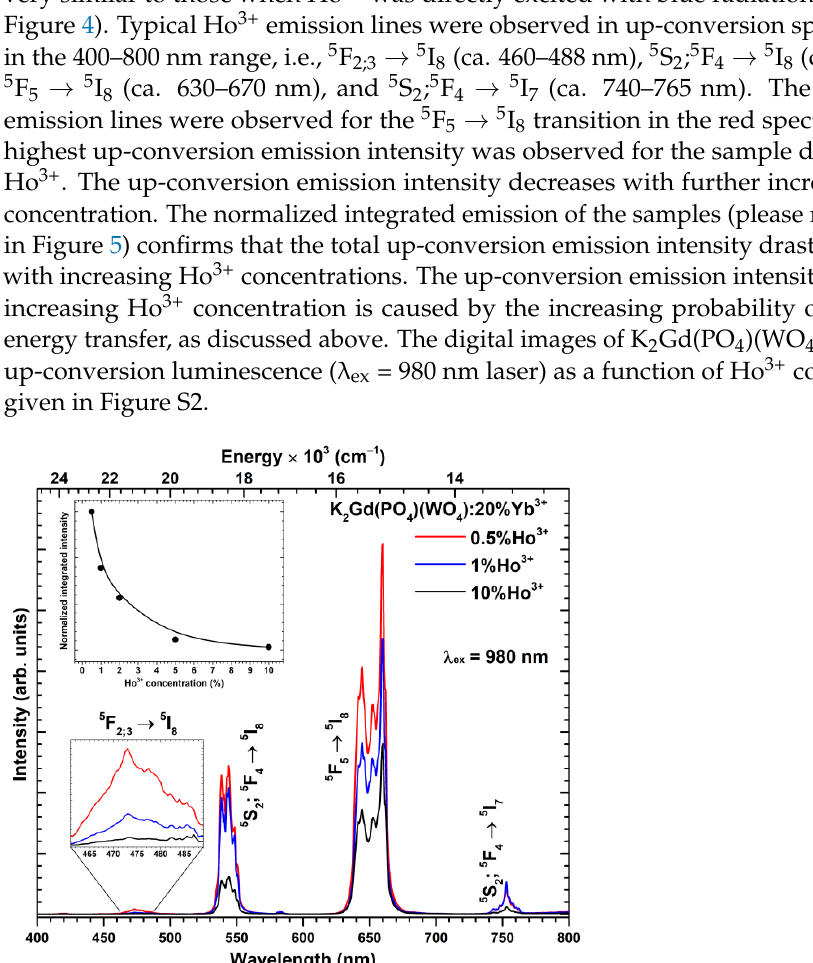
Figure 6a – c, in turn, show the calculated PL rise time and τ eff values of the same samples, respectively. The PL decay curves become steeper with increasing Ho 3+ concentration, in- dicating that PL lifetime values decrease. This indeed is true since the calculated τ eff values decreased from 191 μ s for 0.5% Ho 3+ doped samples to 83 μ s for 10% Ho 3+ doped samples (please refer to Figure 6c). The opposite tendency, however, was observed for the PL rise time values, which increased with increasing Ho 3+ concentration. The exact calculated PL rise time and lifetime values, together with standard deviations, are summarized in Table S6. The calculated UC PL lifetime values for 5 F 5 → 5 I 8 transition are very similar to the ones reported by other authors in a wide variety of materials, i.e., oxides, phosphates, titanates, silicates, tungsten tellurite glasses, and even fluorides. For instance, Guo et al. reported that the UC PL lifetime value of BaGdF 5 :20%Yb 3+ ,1%Ho 3+ is around 131 μs [28] which is close to the 122 μs for our K 2 Gd(PO 4 )(WO 4 ):20%Yb 3+ ,2%Ho 3+ sample. Rather similar UC PL lifetimes were also observed in Sr 3 Y(PO 4 ) 3 :10%Yb 3+ ,2%Ho 3+ (261 μs) and Ba- TiO 3 :3%Yb 3+ ,0.2%Ho 3+ (155 μs for cubi c phase and 125 μs for tetragonal phase) compounds which were reported by Liu et al. [48] and Mahata et al. [11], respectively. However, there are also host matrixes where Ho 3+ UC PL lifetimes are much shorter, for instance, La 9.31 (Si 1.04 O 4 ) 6 O 2 :20%Yb 3+ ,1%Ho 3+ (around 18 μs) [49] and tungsten – tellurite glass (around 33 μs) [50]. An overview of these materials is given in Table 1.